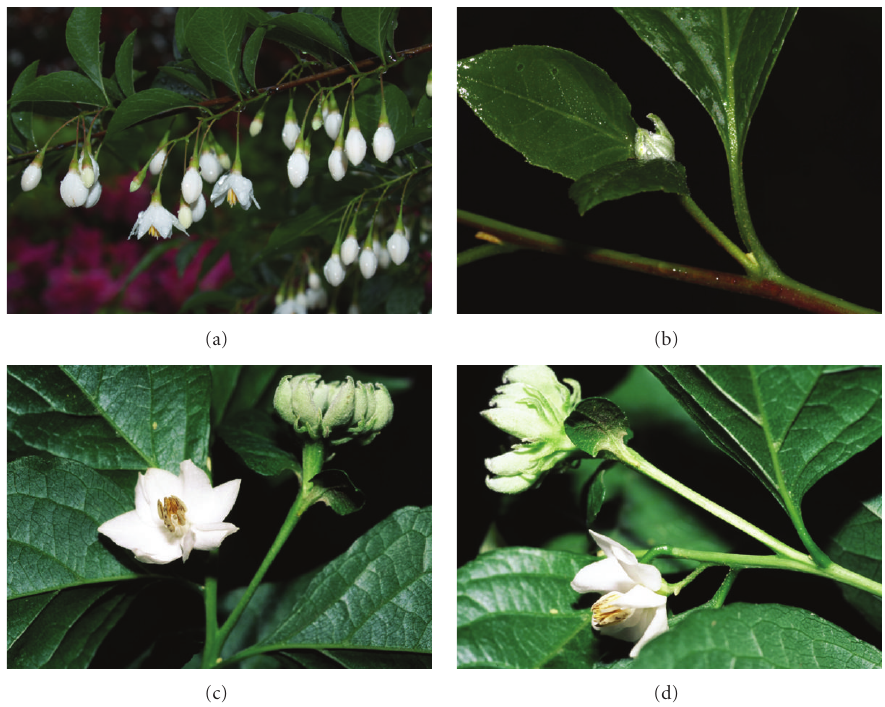
Figure 10: (a) Normal flowers (with five petals) of Styrax japonicus (Niiza, Japan; 6 May 2009). (b) A “gall shoot” that has sprouted from an axillary bud of S. japonicus , with a young gall of Ceratovacuna nekoashi at the apex, two bract-like leaves, and a new axillary bud at the base (Niiza; 6 May 2009). (c) A gall of C. nekoashi and an abnormal flower (with more than five petals) of S. japonicus (Niiza; June 1999). (d) The same abnormal flower shown from a di ff erent angle, indicating that it has sprouted from an axillary bud; petioles of abnormal flowers are variable in length and at times also with bracts (which are absent on this gall-flower